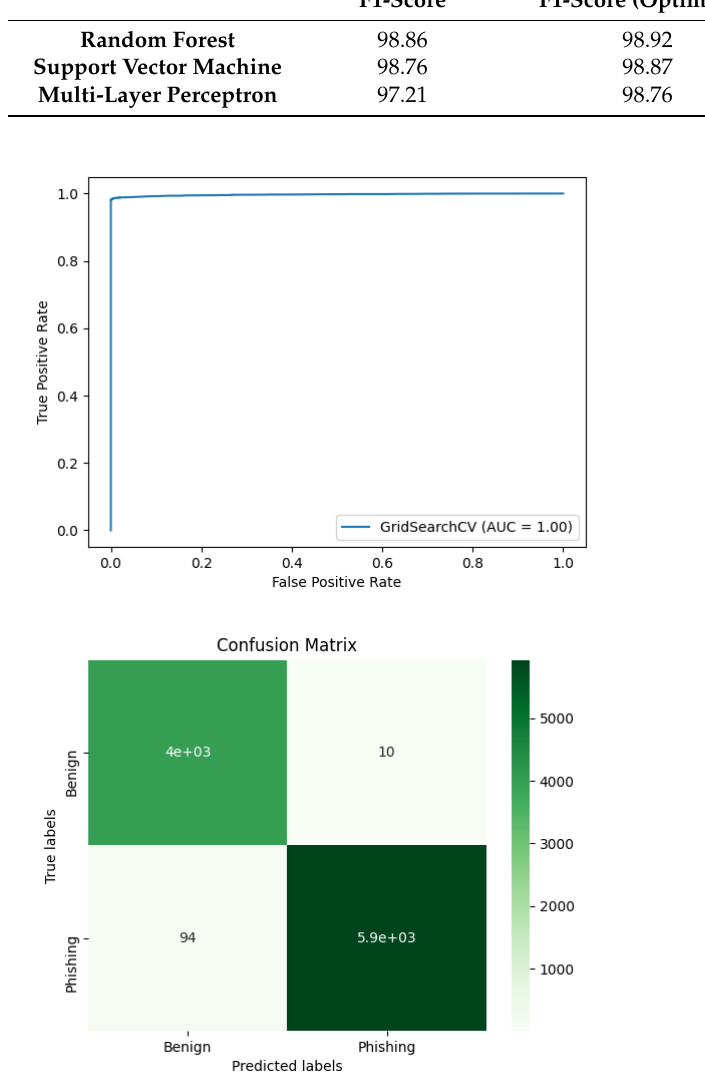
Figure 1. ROC and confusion matrix of the Random Forest